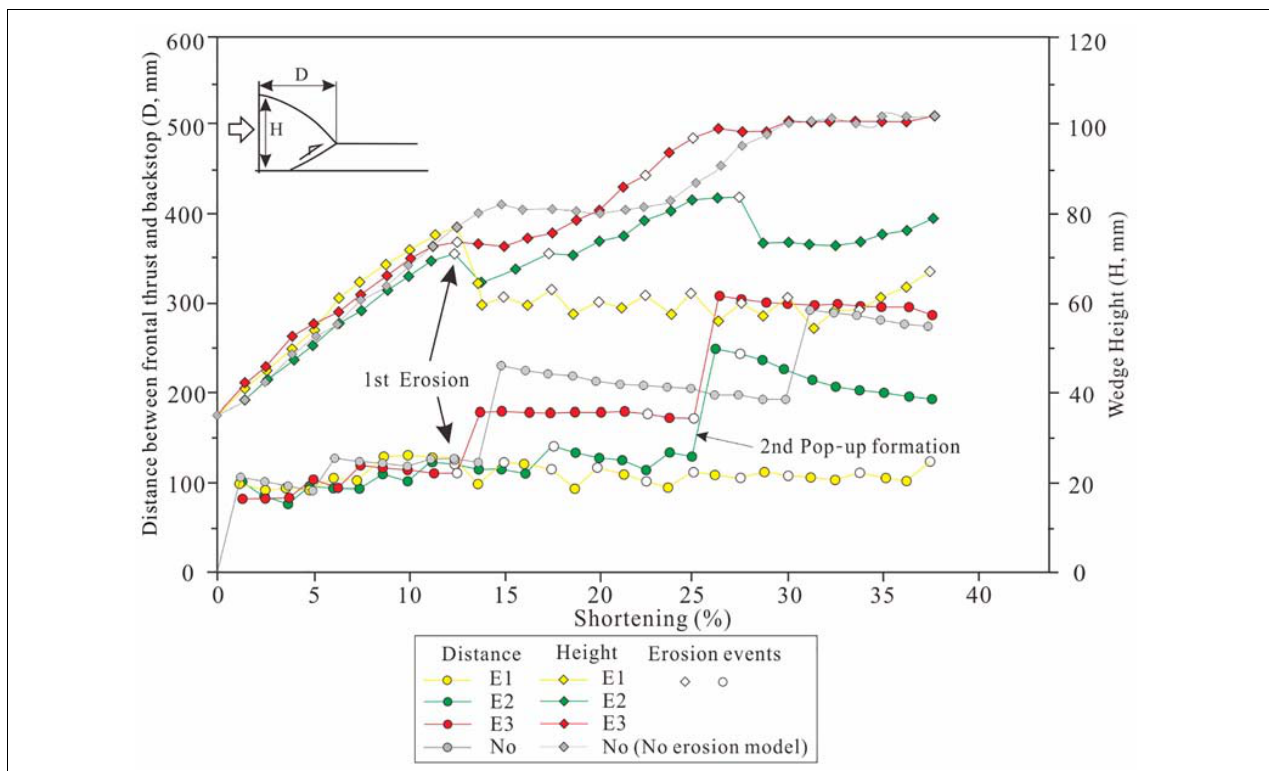
FIGURE 5 | Plot of geometries of accretionary wedge versus shortening in three erosion models. It should be noted that the geometry of no erosion model shows much changes among our